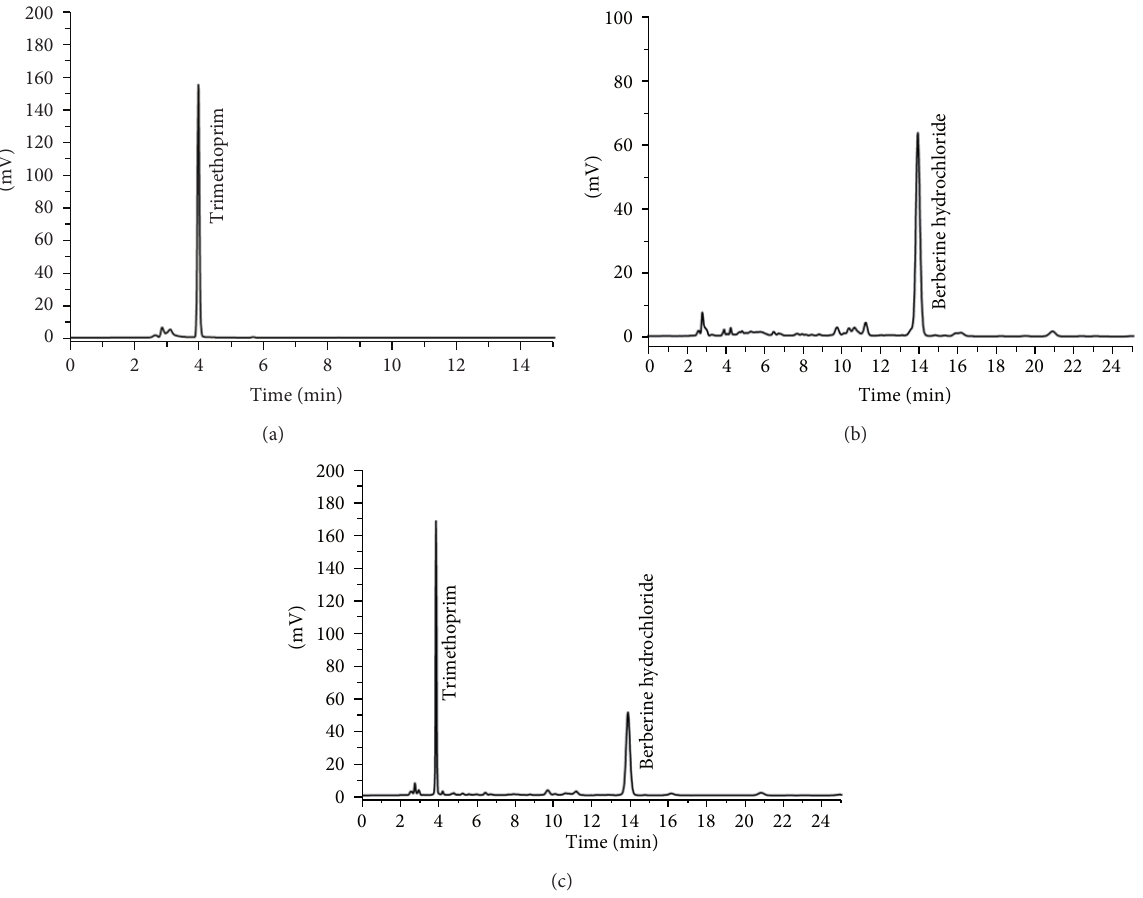
F 3: Typical HPLC chromatograms of alkali hydrolysis degraded (a) trimethoprim, (b) berberine hydrochloride, and (c) combined capsule